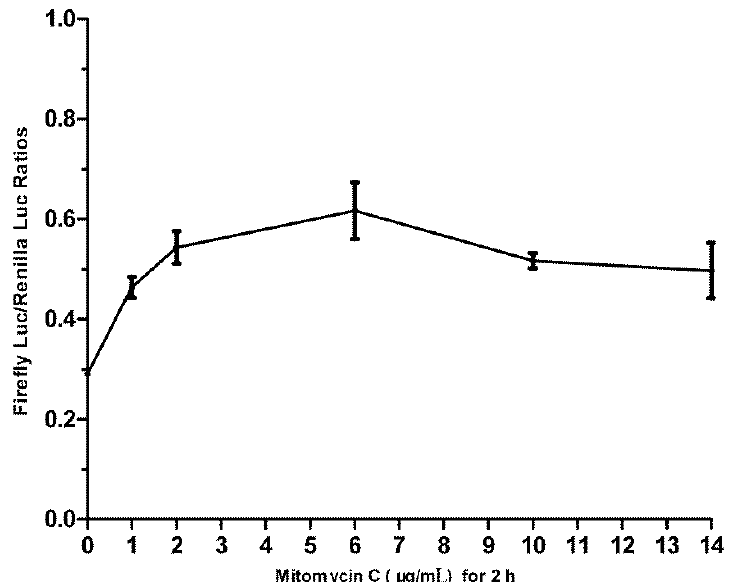
Figure 5. The dose-dependent responses of the stable p21FGLuc cells to model genotoxic and non-genotoxic agents. The stable p21FGLuc cells were exposed to increasing concentrations of bleomycin, mytomycin C and ethanol. Data are expressed as mean ±